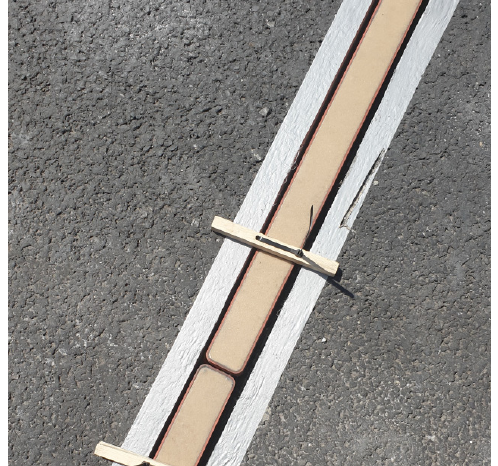
Figure 6. Strain gauge load cell sensors.